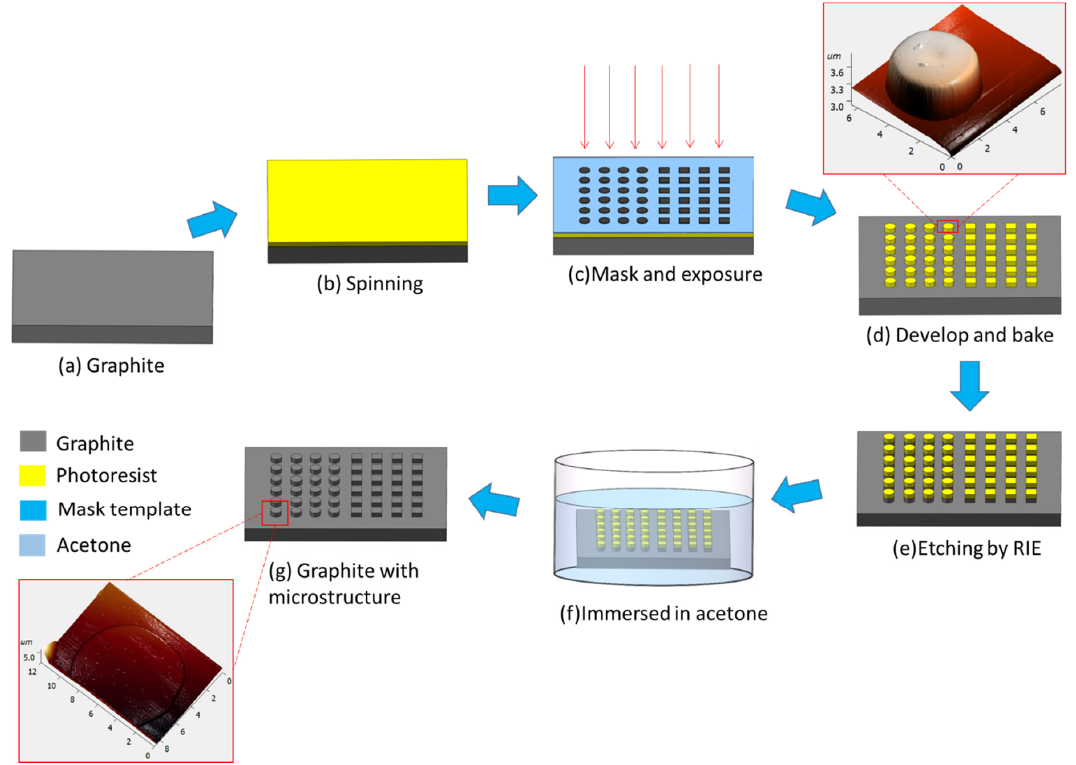
Figure 1. Process diagram of micro-/nanotechnology on graphite surface with directly direct lithography and etch.